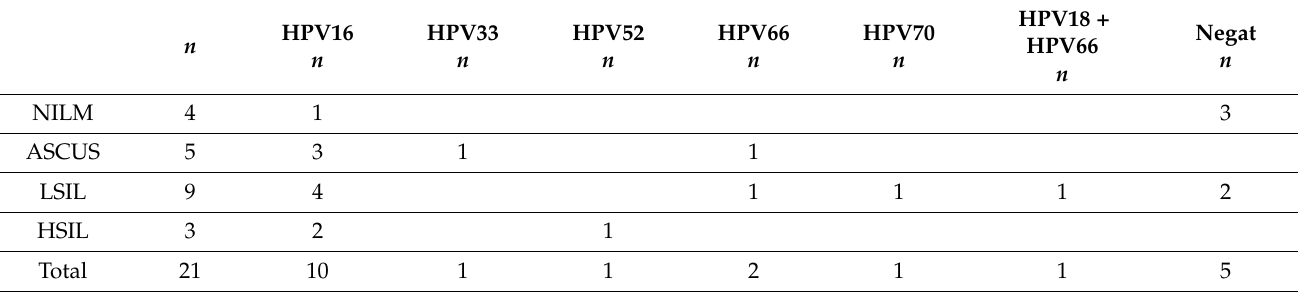
Table 1. The identified HPV genotypes in cervical swabs taken from women with different stage of cervical